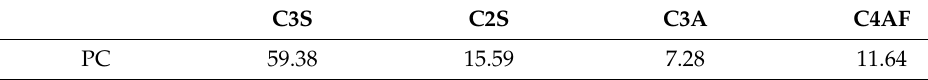
Table 2. Mineral composition of cement (w/%).